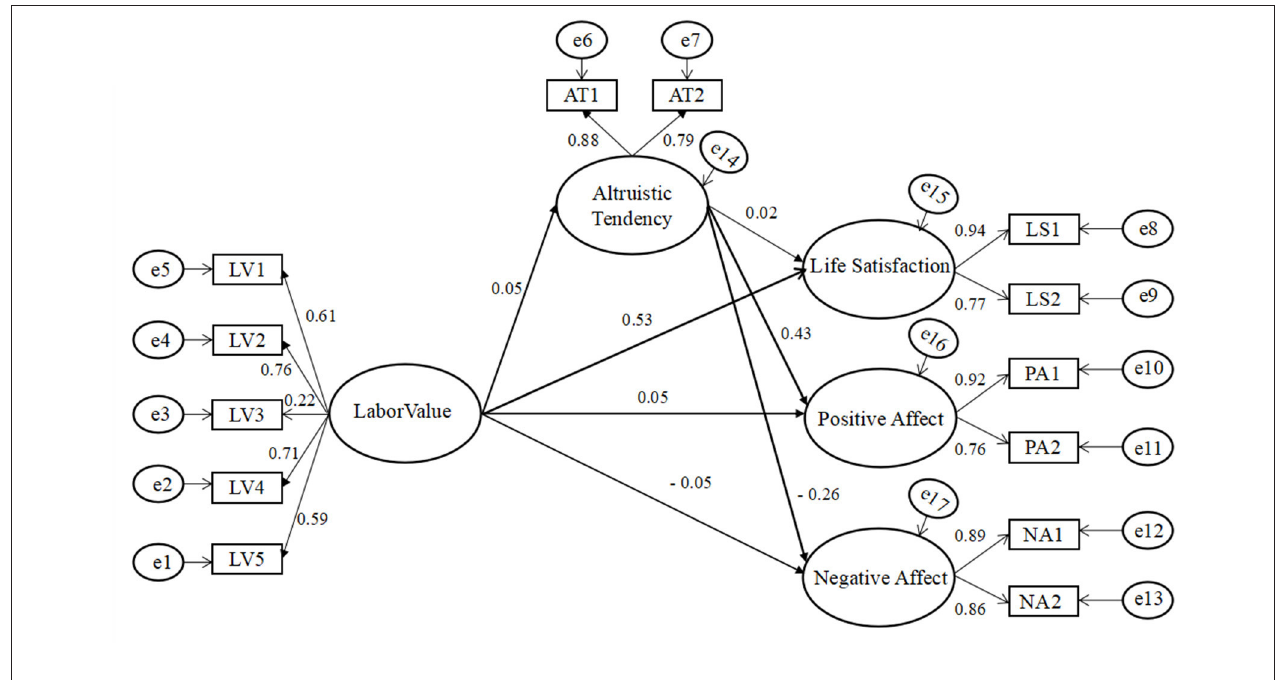
FIGURE 1 | The factor loadings in the mediation model are standardized. TABLE 2 | Fit indices of Model 1.